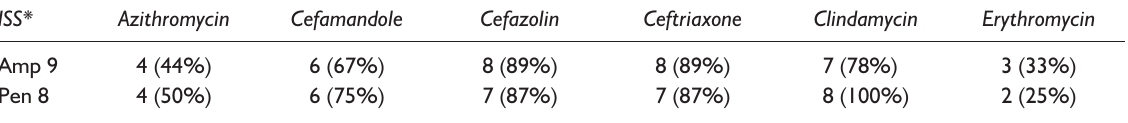
Table 4 Resistance of GBS isolates to other antibiotics among the penicillin intermediate-susceptible strains